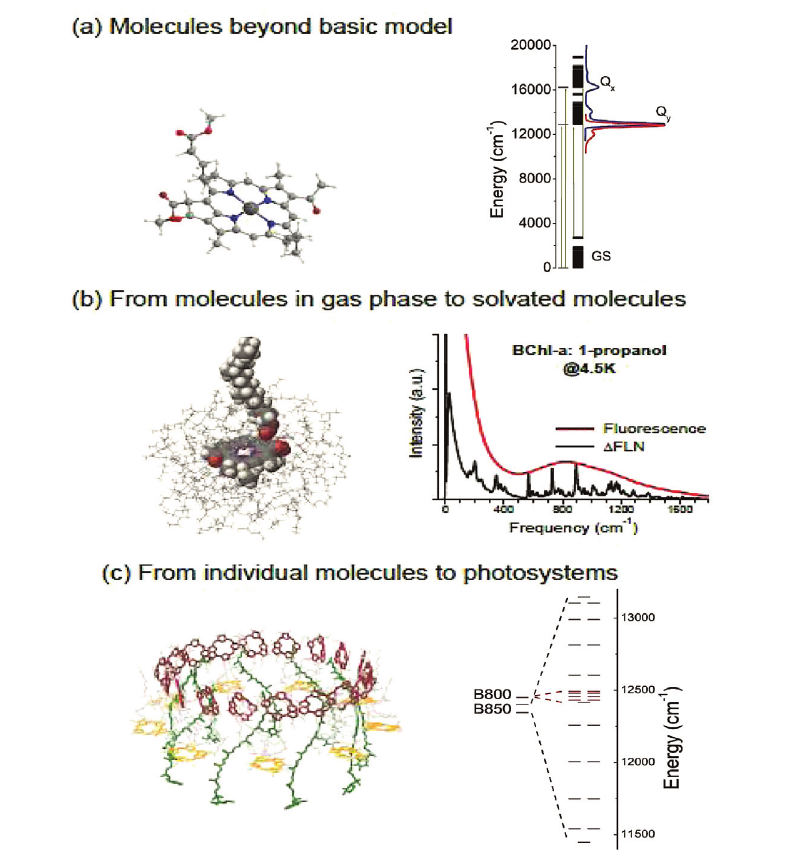
Fig. 1. Bacteriochlorophyll-a (BChl-a) in different environments: (a) gas phase [66]; (b) solid solution of 1-propanol [67]; (c) LH2 light-harvesting pigment-protein complex from Rhodoblastus acidophilus [68]. For simplicity, in the latter structure only pigment molecules are shown: 27 BChl-a (drawn by dark red and yellow colours) and 9 carotenoids (green). See the text for further